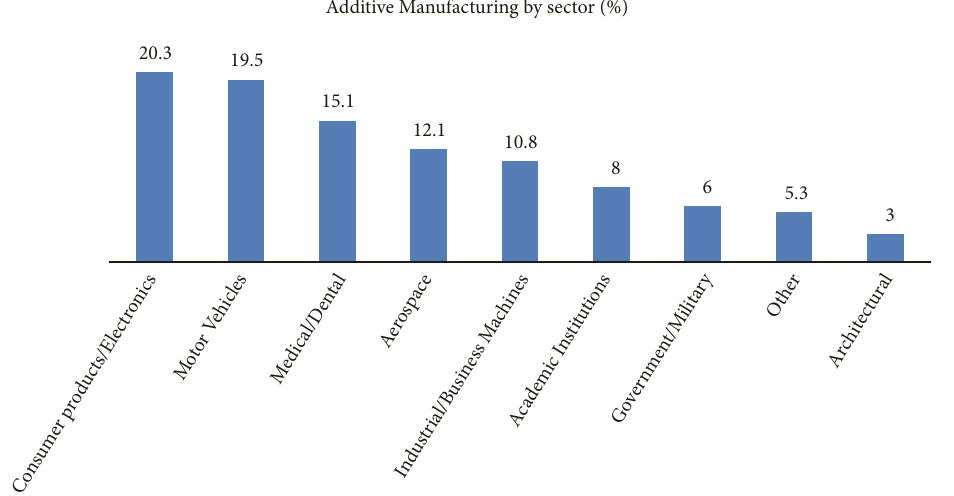
Figure 7: The use of additive manufacturing in the different sectors (Wohlers Report